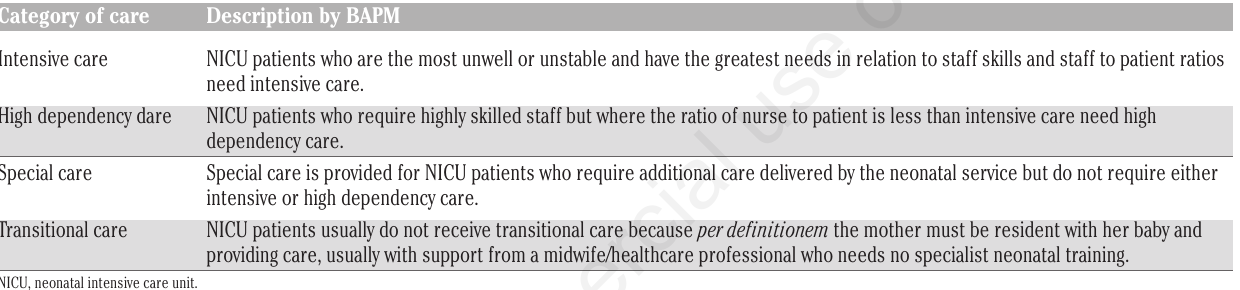
Table 1. Categories of care. Adapted from British Association of Perinatal Medicine (BAPM). 3 Category of care